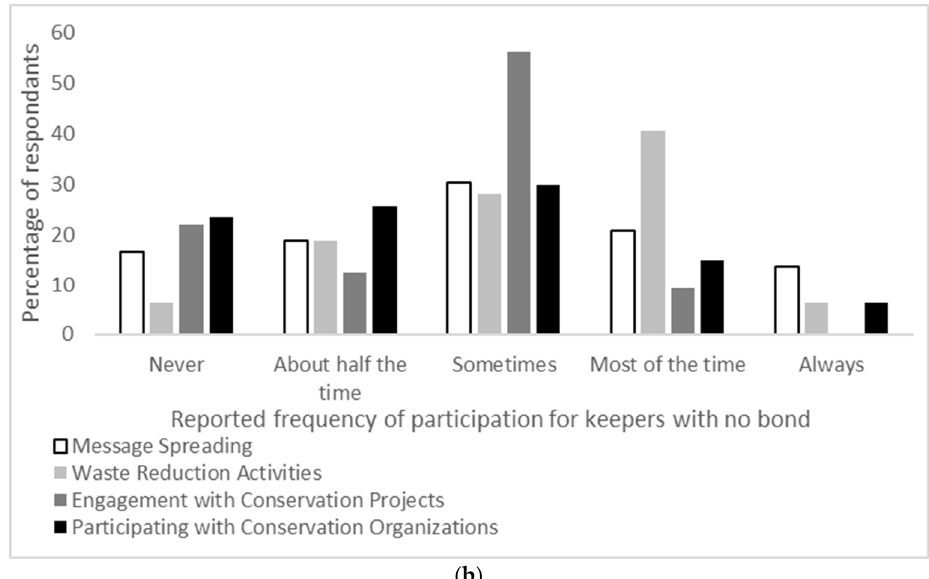
Figure 2. Likelihood of keeper participation in different types of conservation activities that reported a perceived bond with an animal ( a ) and those that did not ( b ).